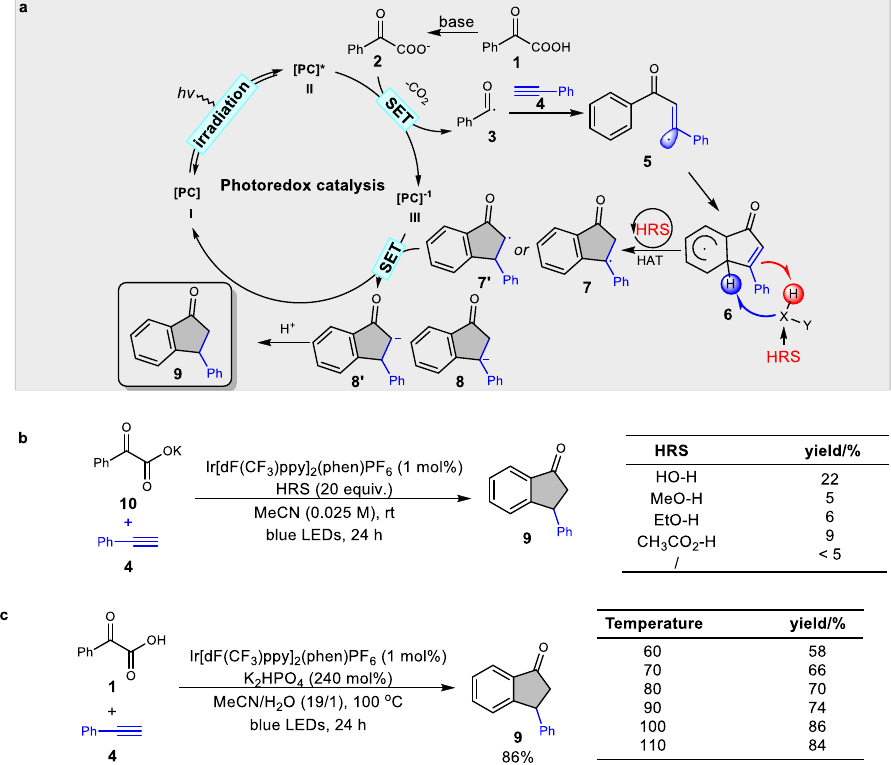
Fig. 2 Reaction development. a Proposed mechanism for synthesis of indanone. b Evaluation of possible HRS catalyst. c Investigation of temperature ’ s effect on the reaction. PC photocatalyst, HRS hydrogen